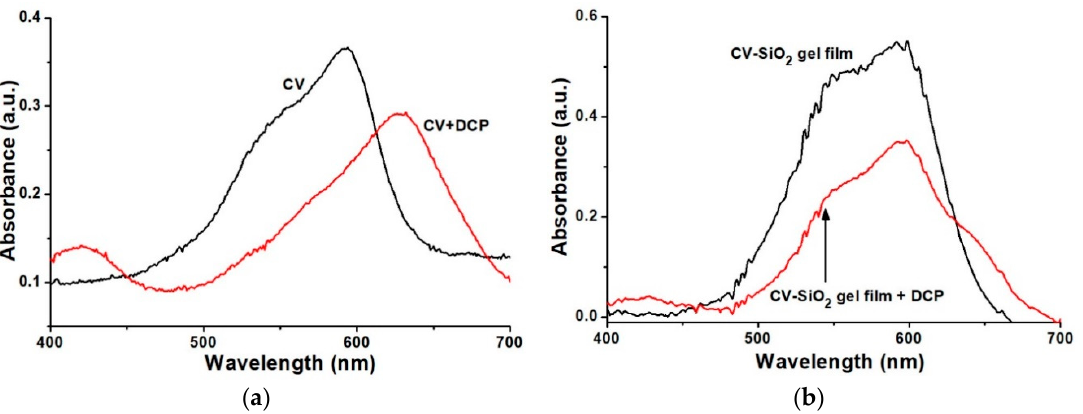
Figure 7. Absorbance change of the CV solution ( a ) and CV-SiO 2 gel film ( b ).